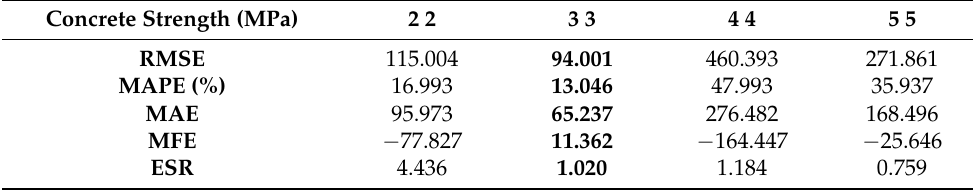
Table 8. Training error results of the ANFIS model with the trapezoid membership function ‘tramf’. Concrete Strength